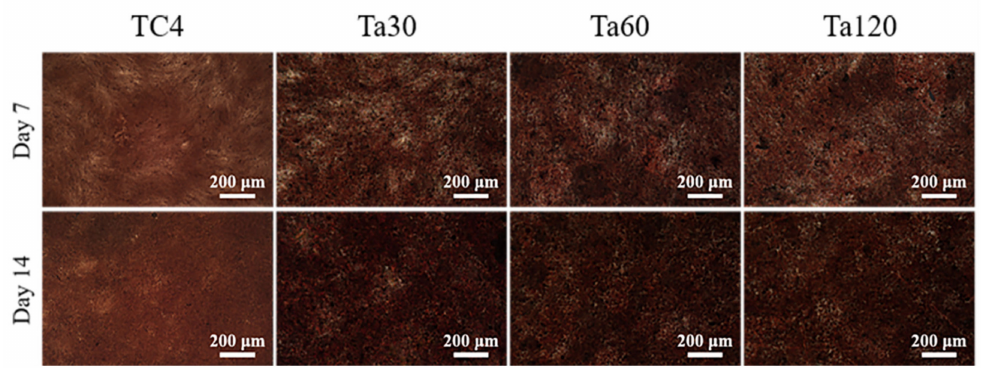
Figure 9. The extracellular matrix mineralization level of Ta coatings after osteogenic induction for 7 and 14 days. Mirror polished TC4 was used as